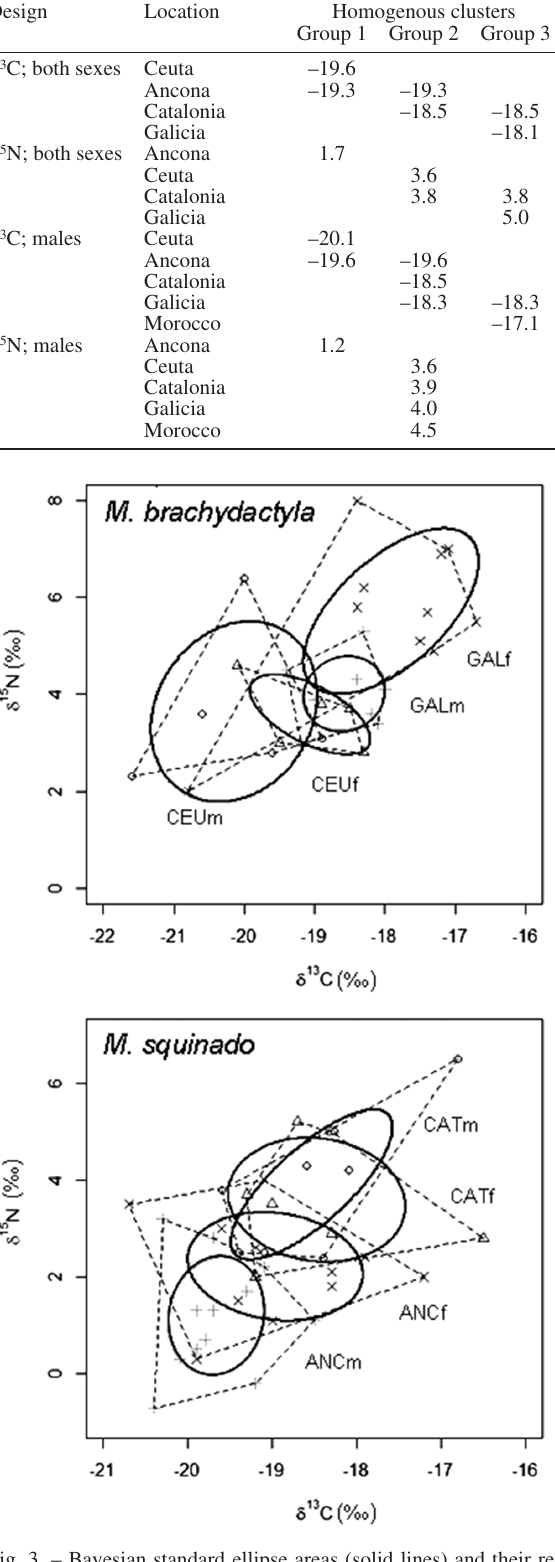
Fig. 3. – Bayesian standard ellipse areas (solid lines) and their re- spective convex hulls (dashed lines) for Maja brachydactyla (top panel) and Maja squinado (bottom panel), calculated by SIBER using the bivariate isotopic values (individual symbols) of each spe- cies, population and